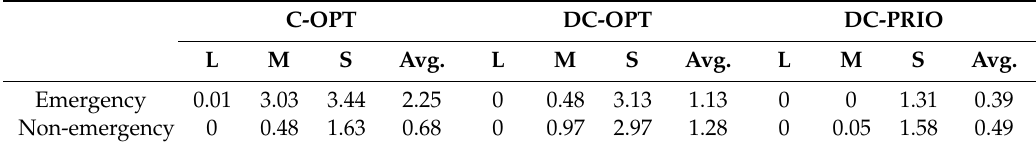
Table 5. Frequency of AD change for the four models. S, small; M, medium; L, large. C-OPT DC-OPT DC-PRIO